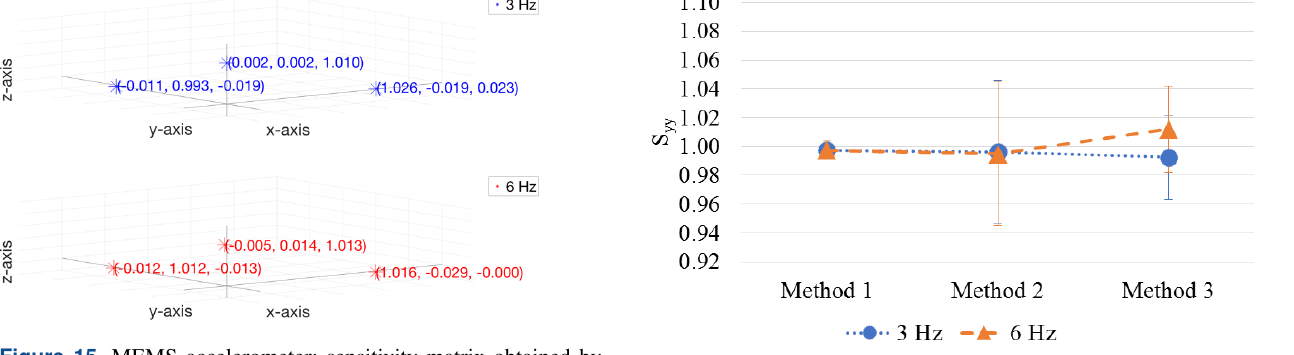
Figure 17. MEMS accelerometer: comparison between methods (main sensitivity along the y axis, S yy ).